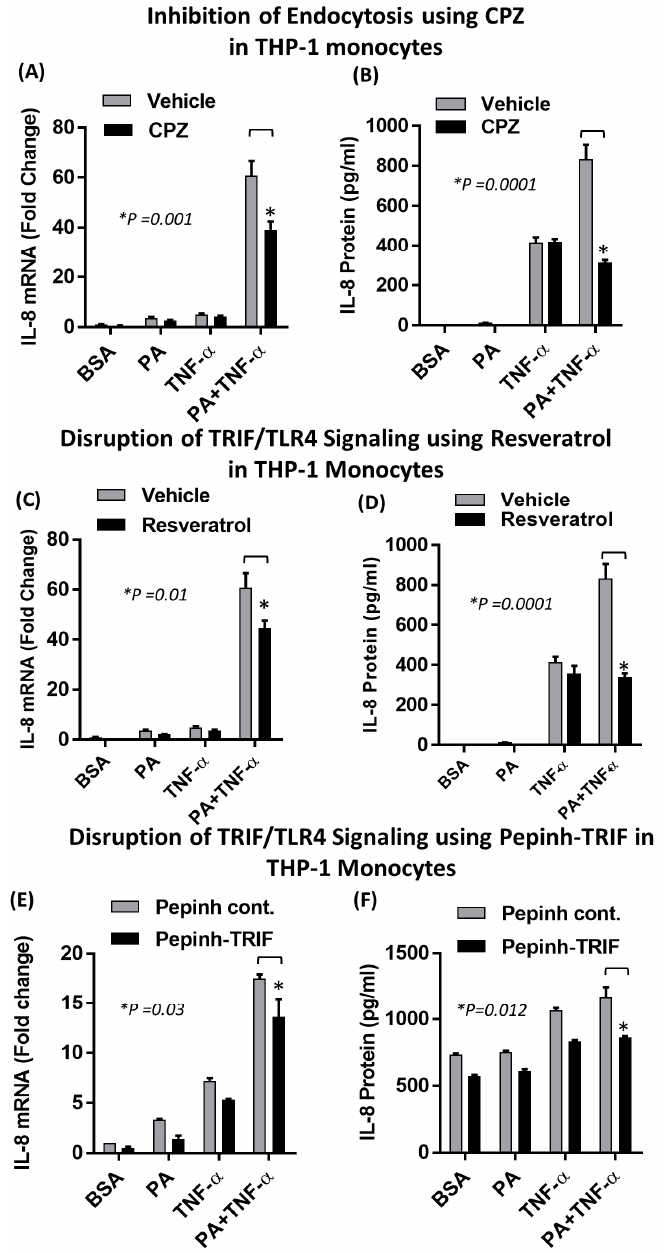
Figure 6. Synergistic IL-8 production by palmitate and TNF- α requires TRIF. ( A , B ) Monocytes were pretreated with chlorpromazine (chlorpromazine (CPZ); an inhibitor of endocytosis; 10 µ M) for 1 h and then treated as indicated for 24 h. Cells were used for the isolation of total RNA to assess the IL-8 gene expression by real-time reverse transcriptase polymerase chain reaction (RT-PCR). Cell culture supernatants were assayed for secreted IL-8 protein as quantified by ELISA. ( C , D ) Monocytes were treated with resveratrol (a TRIF inhibitor; 5uM) for 30 min followed by treatments as indicated. IL-8 expression was determined at both the mRNA and protein levels. ( E , F ) Monocytes were incubated with TRIF Inhibitory Peptide (Pepinh-TRIF is a 30 aa peptide that blocks TRIF signaling by interfering with TLR-TRIF interaction) Pepinh-TRIF: RQIKIWFQNRRMKWKK-FCEEFQVPGRGELH-NH2 (5 µ M) and Control: RQIKIWFQNRRMKWKK-SLHGRGDPMEAFII-NH2 (5 uM) for 5h and then treated for 24h as indicated. IL-8 expression was determined at the mRNA and protein levels. The results obtained from three replicates of each experiment are shown. All data are expressed as mean ± SEM. * Indicates significant difference.